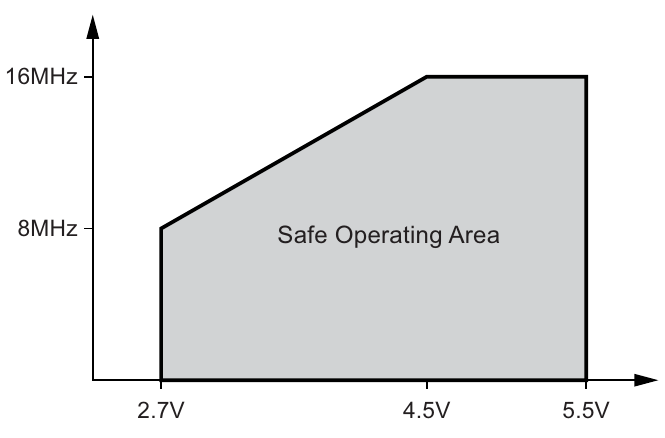
Figure 24. Operational levels of voltage and frequency in ATmega328P.